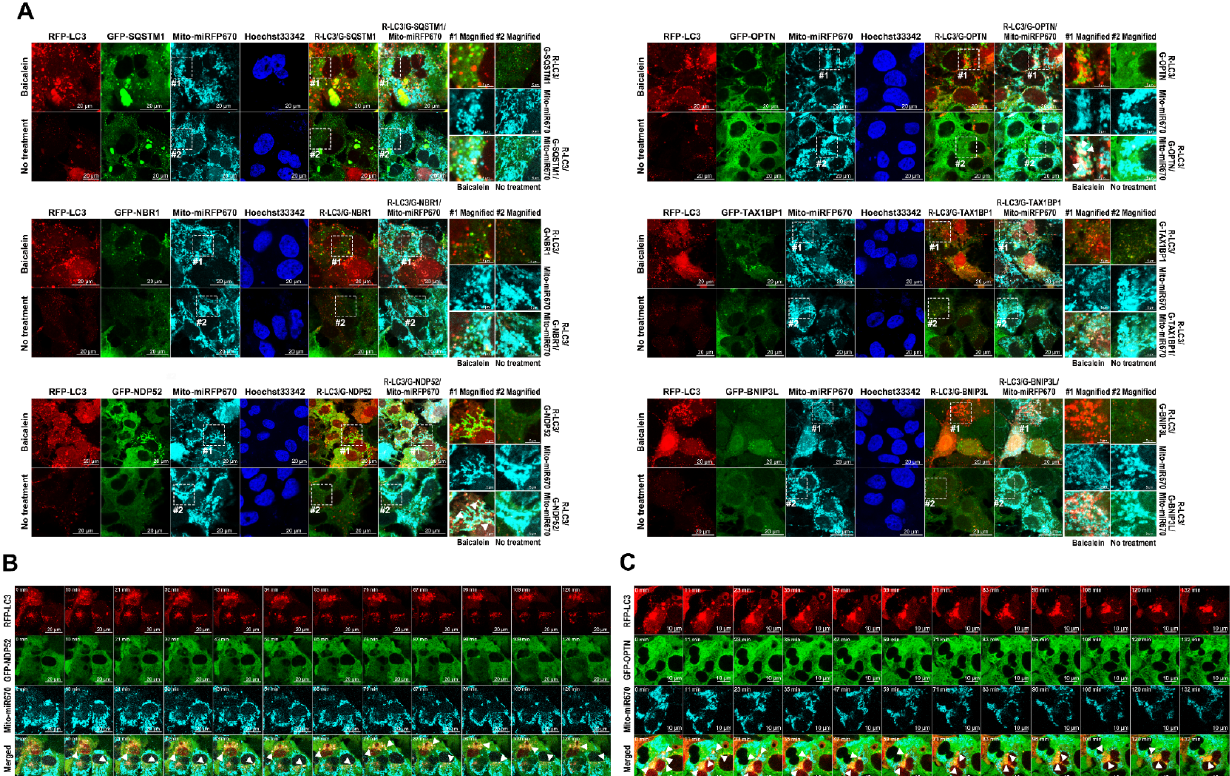
Figure 12. Recruitment of cargo receptors in baicalein-induced mitophagy: ( A ) Huh7/RFP-LC3/Mito-miRFP670 cells expressing individual GFP-cargo receptors as indicated were established. The cells were treated with or without 0.5 mM baicalein. Four hours later, the cells were fixed, stained with Hoechst 33342, and analyzed by confocal microscopy. Magnified field-1 and magnified field-2 in each panel show enlarged images of the areas in white dashed boxes 1 and 2 in the images of baicalein-treated and untreated cells, respectively. The white arrowheads in magnified field-1 indicate the colocalized signal. ( B ) Selected frames show- ing live imaging of 0.5 mM baicalein-treated Huh7/RFP-LC3/Mito-miRFP670/GFP-NDP52 cells. All frames in the live imaging sequence are shown in Supplemental Video S13. In the representative image, the arrowheads indicate the recruitment of GFP-NDP52 in the elimination of Mito-miRFP670 by RFP-LC3 puncta-labeled autophagic vacuoles. ( C ) Selected frames obtained from the live imaging analysis of 0.5 mM baicalein-treated Huh7/RFP-LC3/Mito-miRFP670/GFP-OPTN cells (Supplemental Video S14) are shown. In the representative image, the arrowheads indicate the coordination of GFP-OPTN with RFP-LC3 puncta-labeled au- tophagic vacuoles in the turnover of Mito-miRFP670.